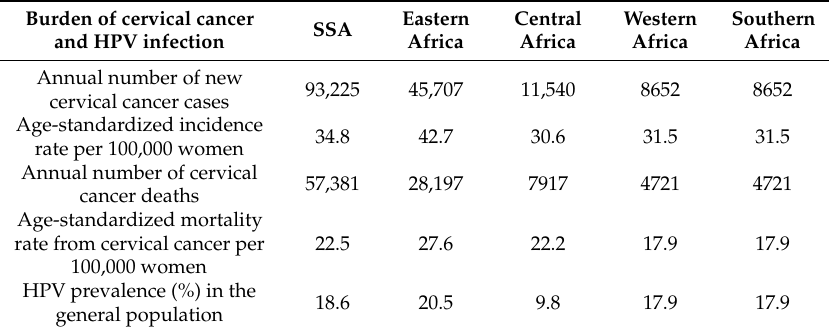
Table 1. Key Epidemiological Data for Cervical Cancer and HPV for SSA regions [2,8]. Burden of cervical cancer and HPV